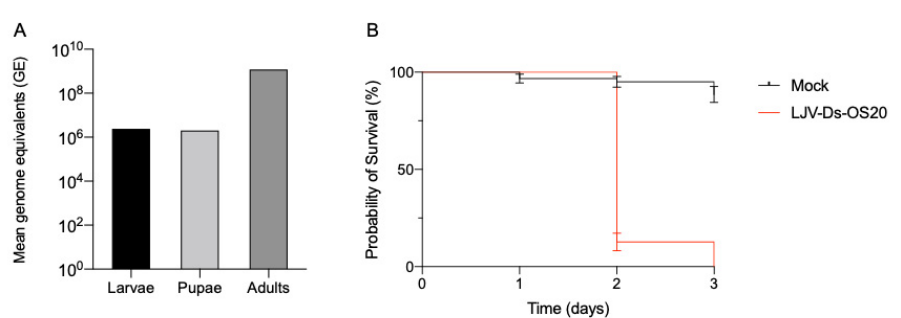
Figure 2. LJV-DsOS20 virus production system. ( A ) LJV was injected in larvae, pupae and adult flies, showing higher virus genome equivalents in adults than in pupae and larvae. ( B ) When virus was injected in female flies, fast mortality was observed in infected flies. Experiments have been performed three times, p < 0.001 for log-rank